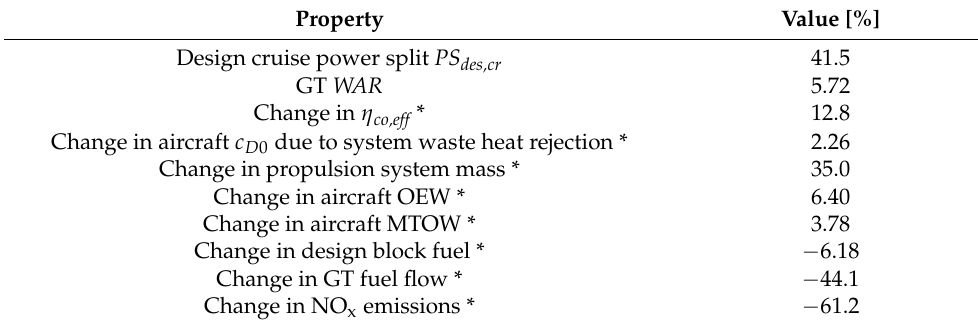
Table 5. Summary of key characteristics for block optimum aircraft from Figure 11.